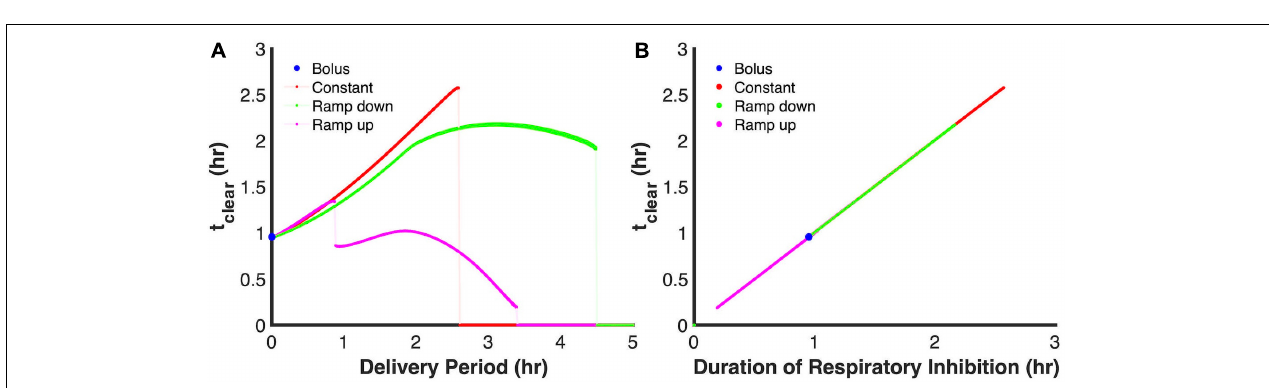
FIGURE 6 | Duration of respiratory inhibition is a strong predictor of t clear . (A) Model predictions using the ensemble of parameter sets (ER < 10, 28 sets in total) for t clear as a function of delivery period when a 24 µ mol PAPA NONOate payload is delivered. Solid lines represent the predicted relationship between t clear and delivery period (bolus- blue; constant-red; ramp down-green; ramp up-pink), while the lightly shaded lines represent discontinuities in the curves. (B) Plot of duration for respiratory inhibition vs. t clear . Duration of respiratory inhibition was defined as the length of time for which the percentage of NO bound cytochromes ≥